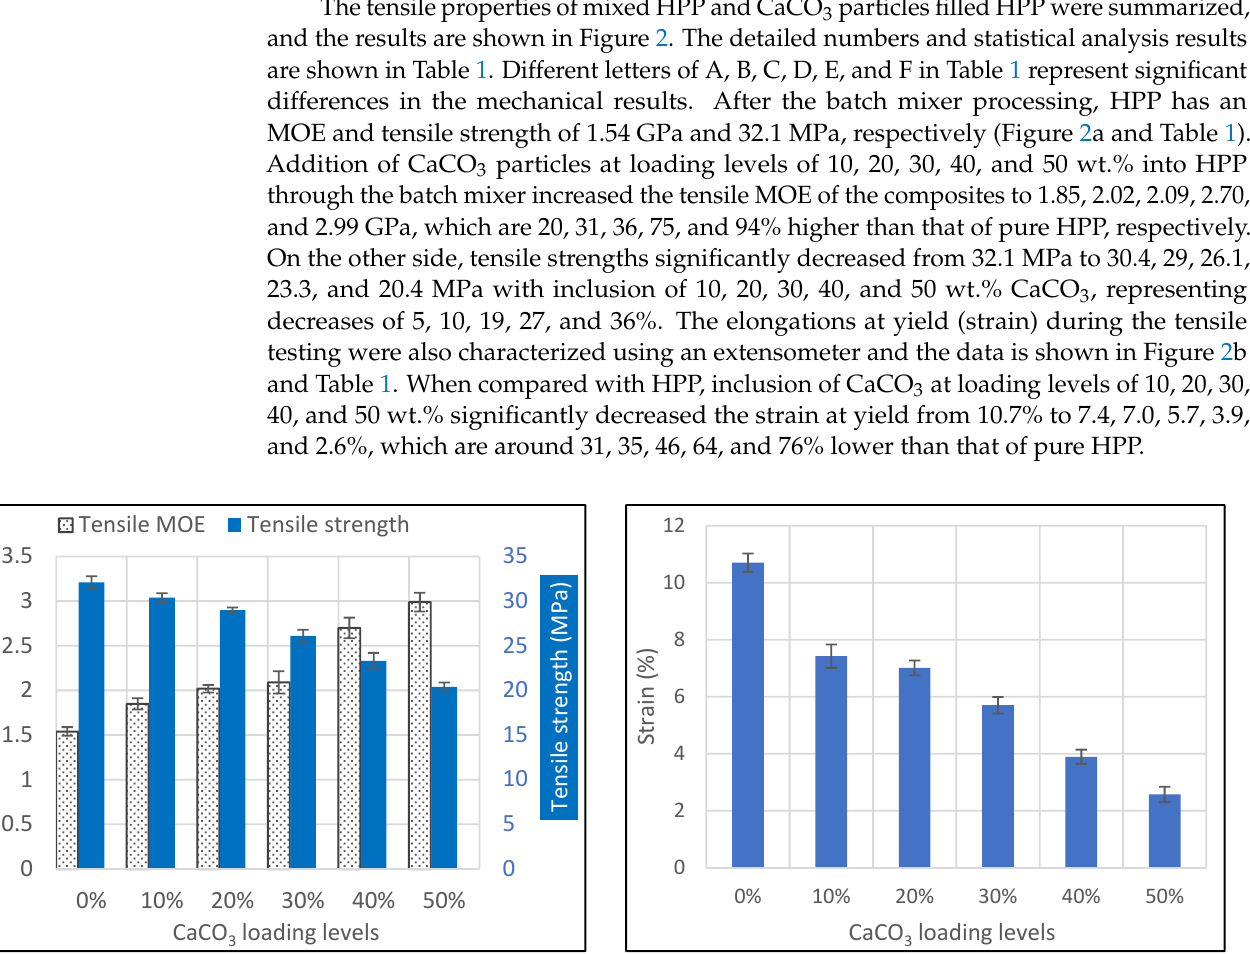
Figure 1. SEM micrographs of CaCO 3 particles at different magnifications ( a ) 5000× and ( b ) 2000×.